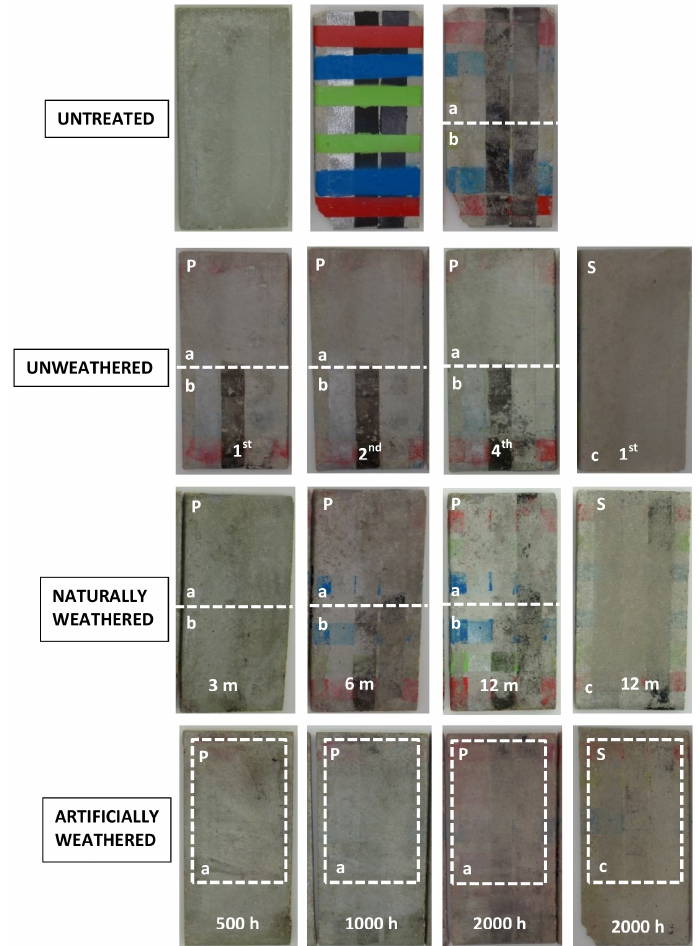
Figure 6. Graffiti removal on untreated concrete, treated with the permanent (P) and sacrificial (S) anti-graffiti coatings before ageing (1st, 2nd and 4th cycles) and after natural (3, 6 and 12 months) and artificial weathering (500, 1000 and 2000 h). Cleaning methods: ( a ) detergent and brush; ( b ) detergent and high pressurized water spray; ( c ) high pressurized hot water spray.